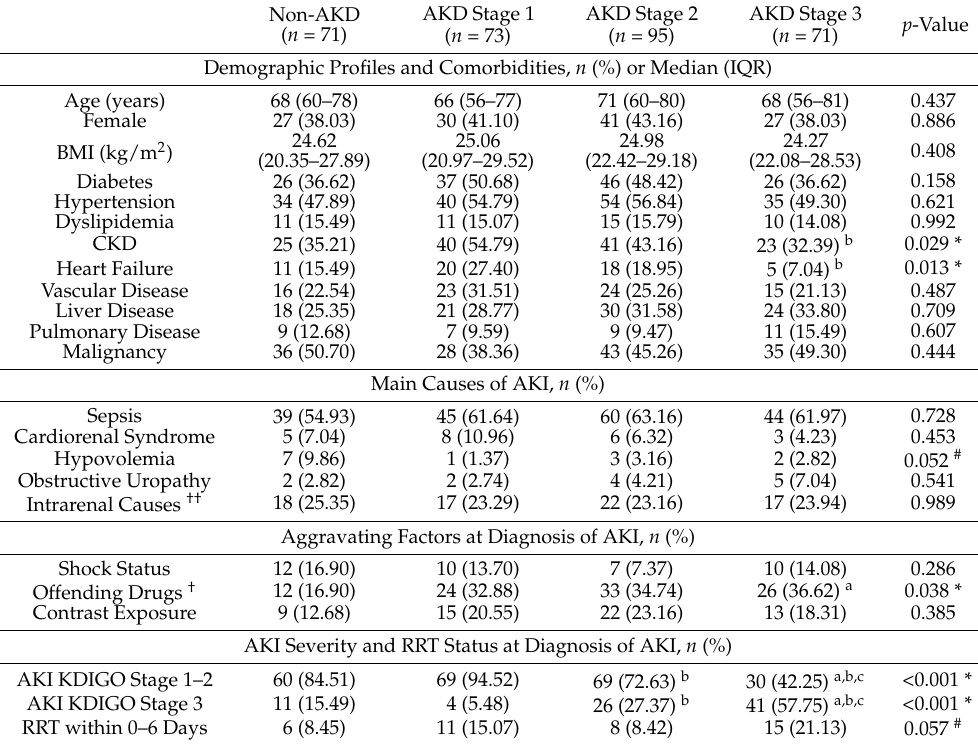
Table 2. Factors Associated with AKD Severity in patients with